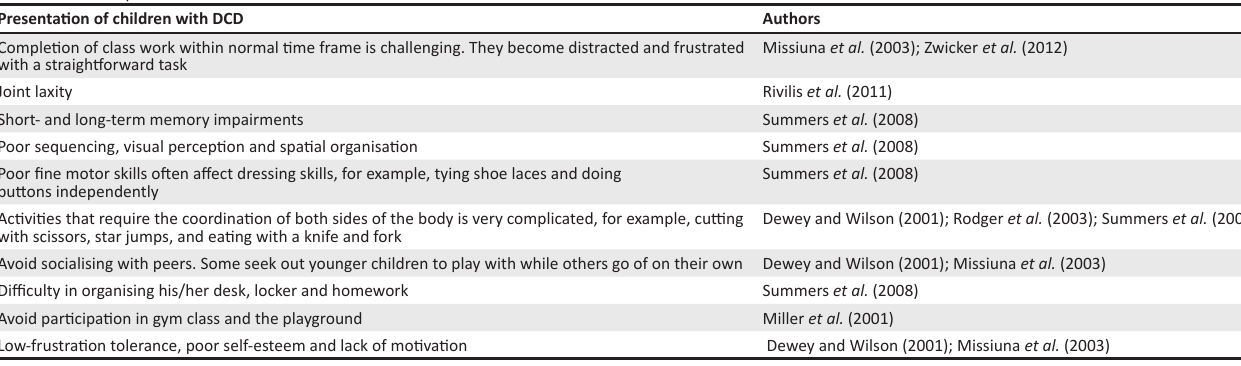
TABLE 1: Clinical presentation of children with